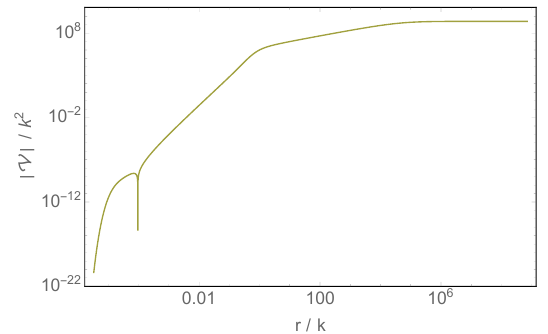
Figure 5 . Plot of the Schr(cid:127)odinger potential jVj , de(cid:12)ned in (4.7), for a massive scalar (cid:12)eld with m 2 = (cid:0) 2. Note that V has a zero at r=k (cid:24) 9 : 5 (cid:2) 10 (cid:0) 5 . The deformation parameter is (cid:0) =k = 0 : 7 (cid:2) 10 5 and the intermediate scaling behaviour is between 10 (cid:0) 4 < r=k < 1 and 1 < r=k < 10 4 . The plot shows a clear separation of scales for the values of the potential in these